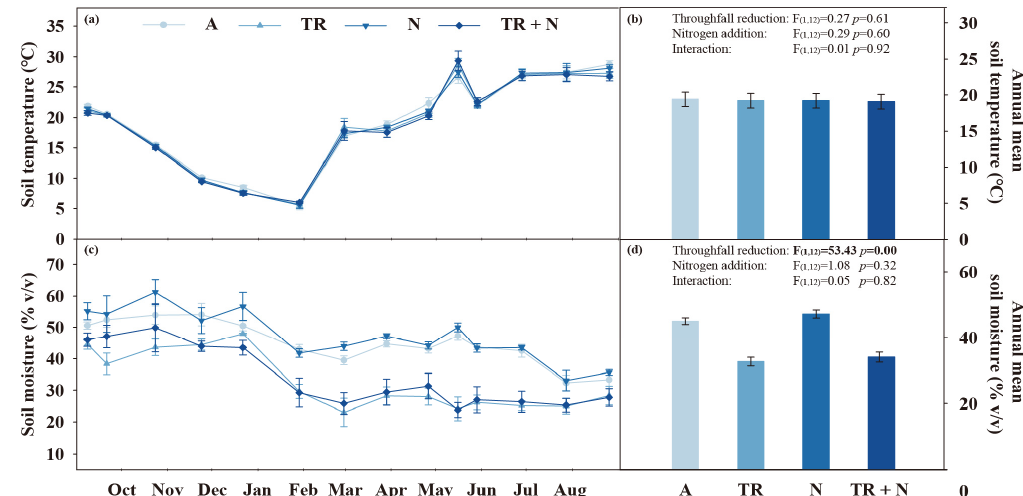
Figure 1. Temporal variation of soil temperature (Graph ( a , b )) and soil moisture (Graph ( c , d )) under ambient (A), throughfall reduction (TR), N addition (N) and throughfall reduction, and N addition (TR + N) treatments from September 2017 to August 2018. The error bar represented arithmetic means ± stand errors for four replicates.